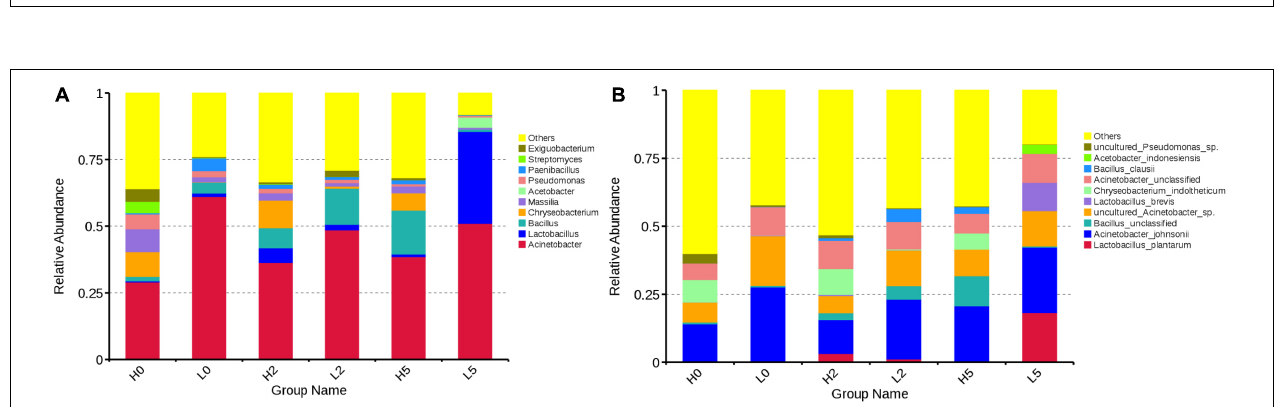
FIGURE 2 | Non-metric multi-dimensional scaling based on Bray-Curtis dissimilarities in bacterial (A) and fungal (B) communities in whole-plant corn silages ( n = 3). H, ensiled whole corn plants with a high moisture content (680 g/kg) harvested at the one-third milk-line stage; L, ensiled whole corn plants with a low moisture content (620 g/kg) harvested at the two-thirds milk-line stage.